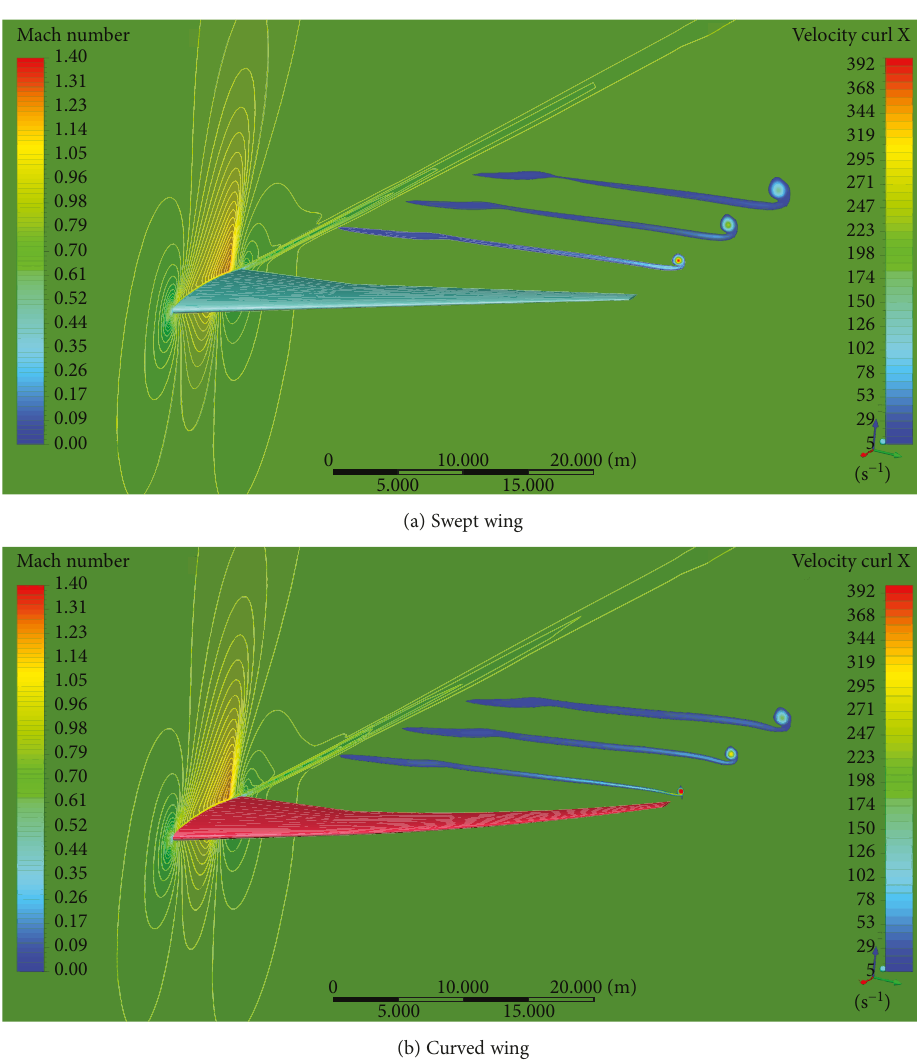
− 29 m , -39m, -40m; h = 10,000m , C P =